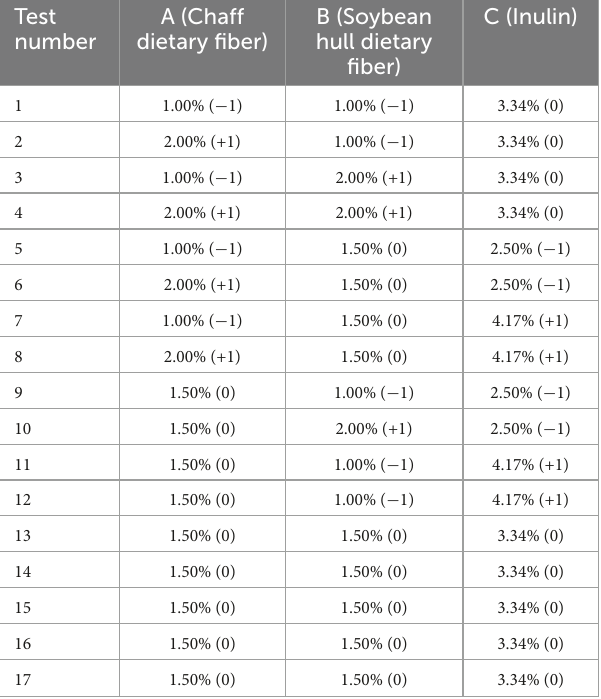
TABLE 1 Response surface experimental